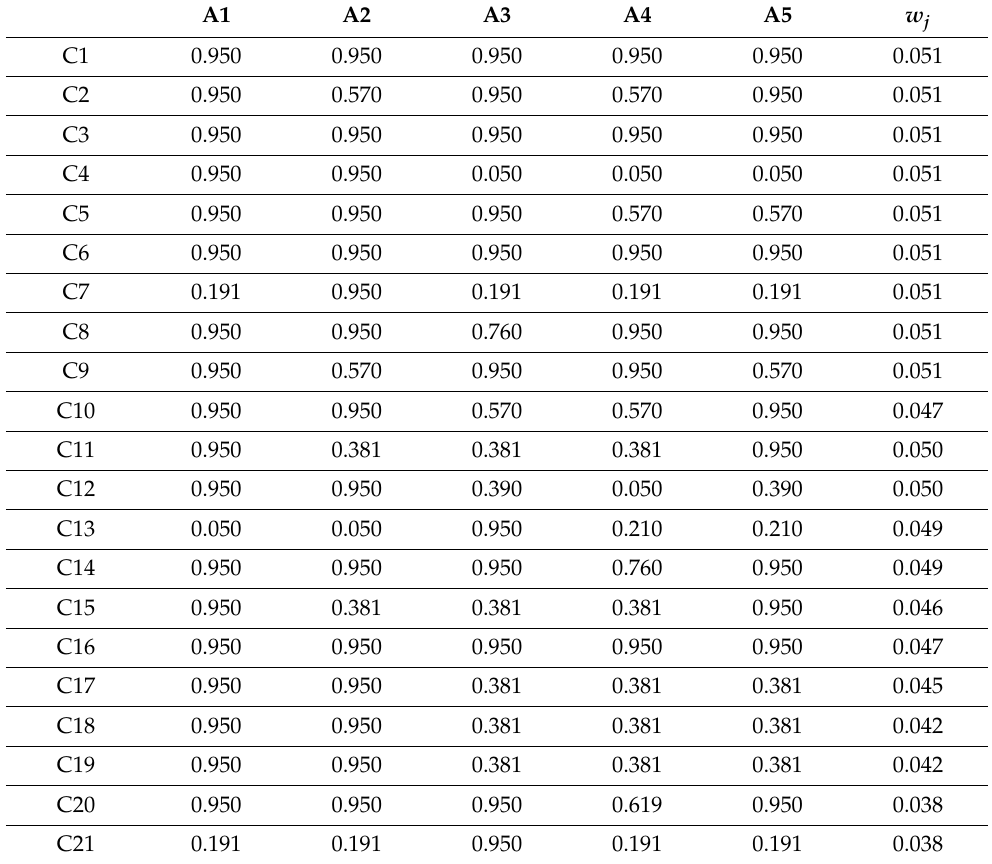
Table 3. Normalized decision matrix T and weighted coefficients w j (crisp